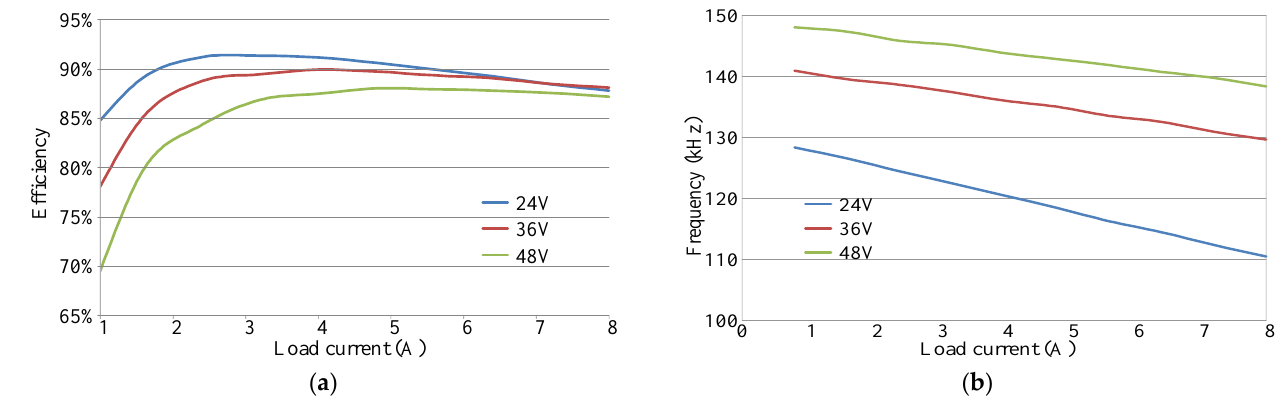
Figure 8. Measured curves of conversion efficiency and switching frequency: ( a ) conversion efficiency; ( b ) switching frequency.